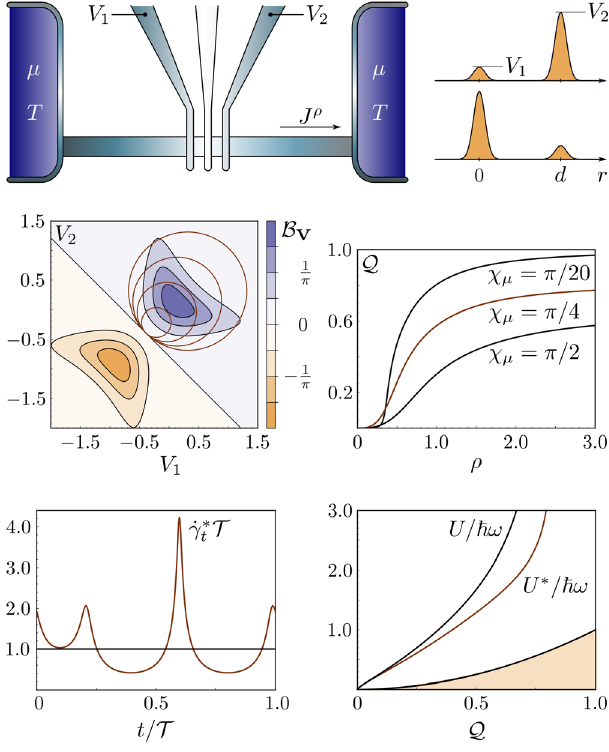
FIG. 3. Parametric quantum pump. Top: sketch of a generic setup. A narrow conductor connects two reservoirs with the same chemical potential and temperature. Periodically changing the gate voltages V 1 and V 2 creates two oscillating potential barriers driving the pump current J ρ . Middle: the left plot shows the Berry curvature B V for χ μ ¼ π = 4 . Circles indicate the control path that is determined by the protocols (61) for ρ ¼ 1 = 4 ; 1 = 2 ; 3 = 4 ; 1 . As the path expands into the positive peak of B V , the pump flux Q first increases sharply and then approaches a limit value, which depends on the parameter χ μ . Bottom: the left-hand panel shows the optimal driving speed _ γ (cid:2) for χ μ ¼ π = 4 and ρ ¼ 1 . The t horizontal line corresponds to constant speed. On the right, the energy uptake is plotted against the pump flux for constant and optimal driving speed U and U (cid:2) , respectively, where χ μ ¼ π = 4 and ρ varies between 0 and 5. The shaded area indicates the bound